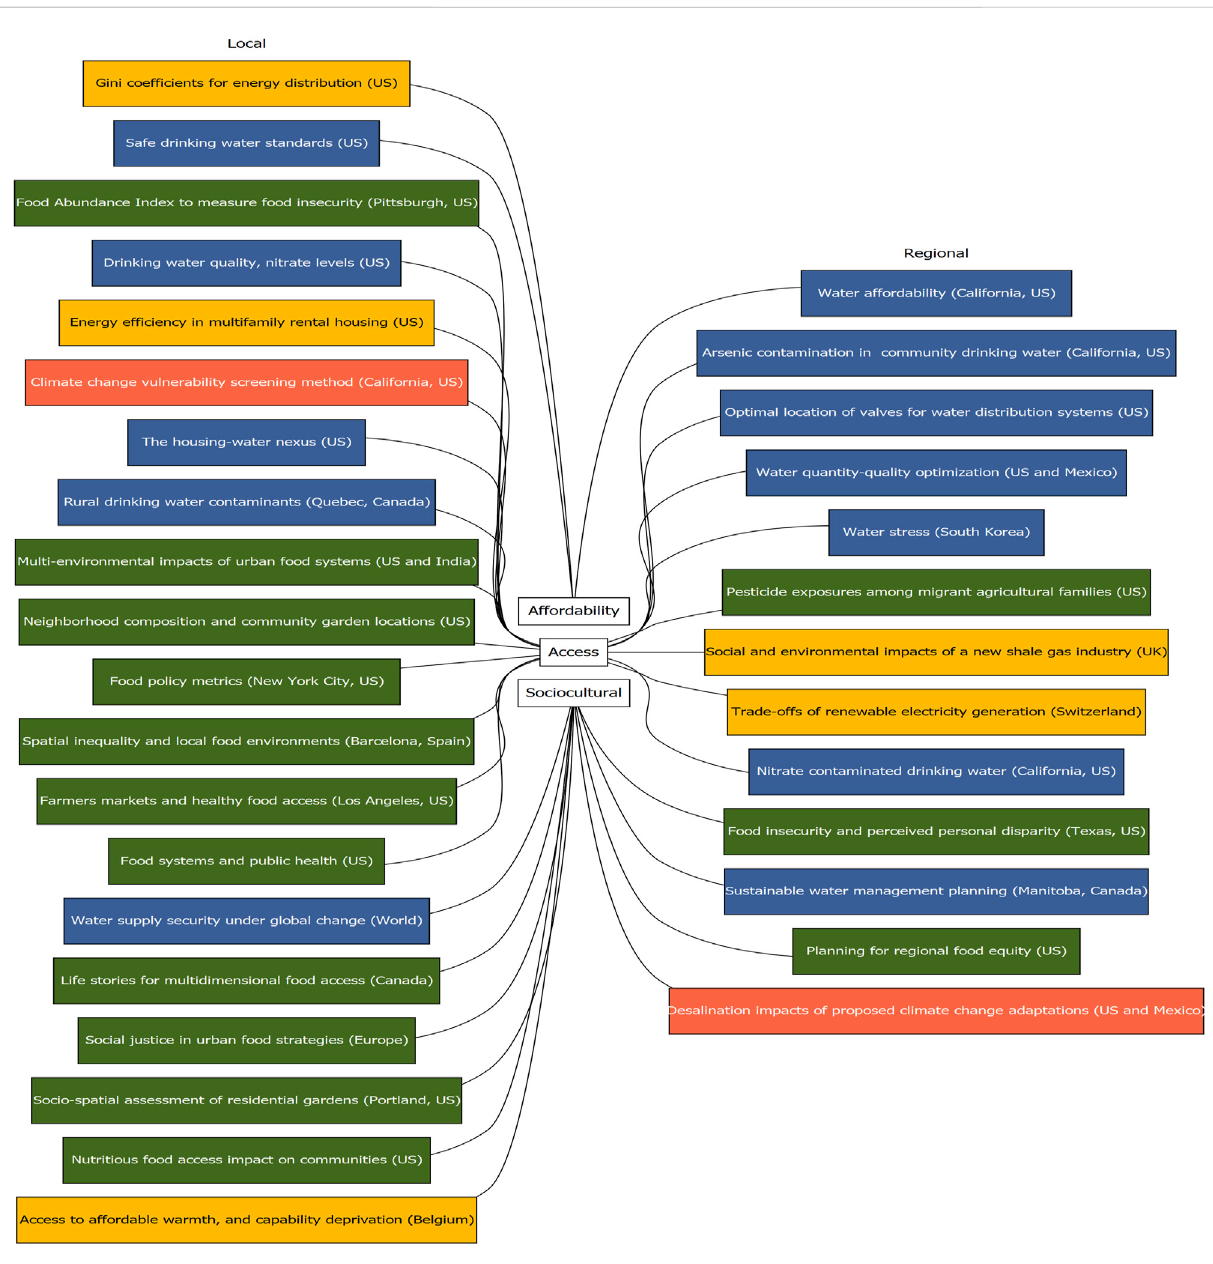
Frontiers in Environmental